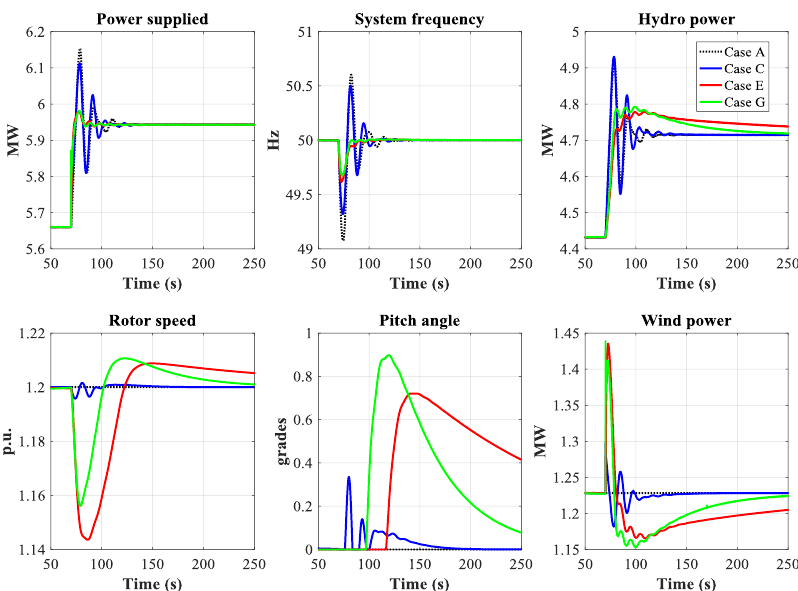
Figure 9. Comparison of the dynamic response of the system between the base case and the case in which VSWT contributes to frequency regulation by combining the inertial and proportional control, and by considering a sudden power demand variation and a constant wind speed of w s = 10 m/s.